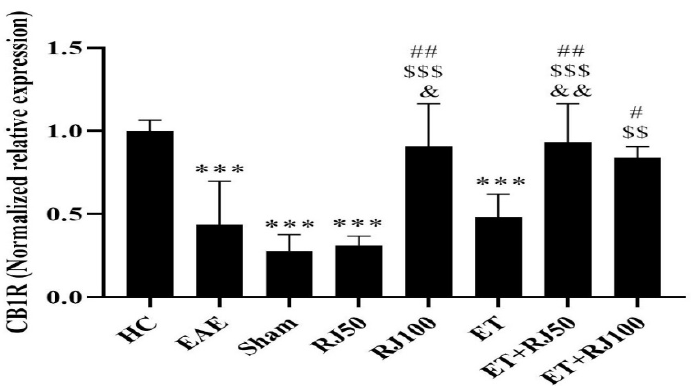
Figure 4. CB1R gene expression levels in the hippocampal tissue of rats in the research groups. EAE reduced CB1R, while RJ100, ET + RJ50, and ET + RJ100 increased CB1R. Each value is the mean ± SD. *** ( p ≤ 0.001): significant decrease compared to the HC group. # ( p ≤ 0.05), ## ( p ≤ 0.01): significant increase compared to the EAE group. $$ ( p ≤ 0.01): significant increase compared to the RJ50 group. & ( p ≤ 0.05) and && ( p ≤ 0.01): significant increase compared to the ET group. Healthy control (HC); experimental autoimmune encephalomyelitis (EAE); 50 mg/kg royal jelly (RJ50); 100 mg/kg royal jelly J (RJ100); exercise training (ET); exercise training + 50 mg/kg royal jelly (ET + RJ50); exercise training + 100 mg/kg royal jelly (ET + RJ100).